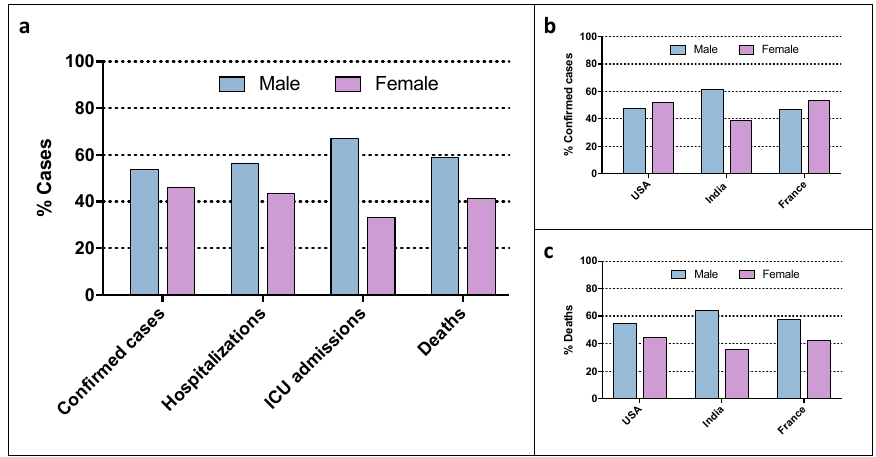
Figure 1. ( a ) Sex-stratified incidence and outcome of patients who tested positive for COVID-19 globally; ( b , c ) sex-stratified incidence ( b ) and death ( c ) of patients who tested positive for COVID-19 in the three countries with most confirmed COVID-19 cases. ICU, intensive care unit. Source: the COVID-19 Sex-Disaggregated Data Tracker, as of 26 October 2021.